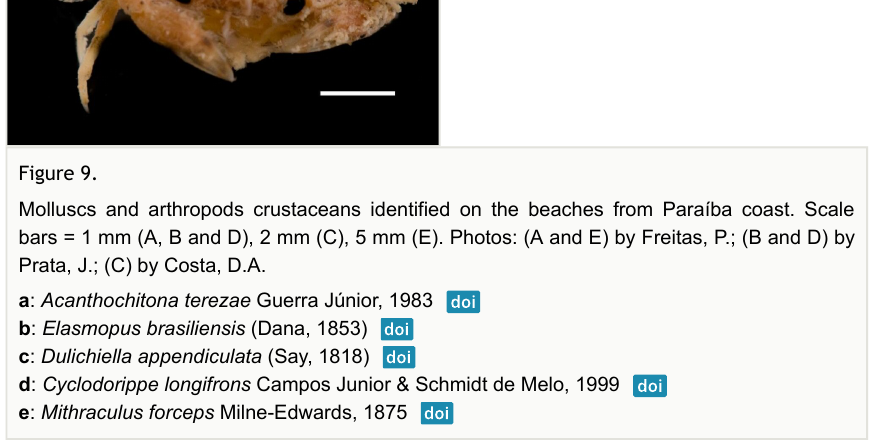
Distribution in Paraíba : Paraíba River Estuary (Lima et al. 2017) and Seixas Beach ( New record ).